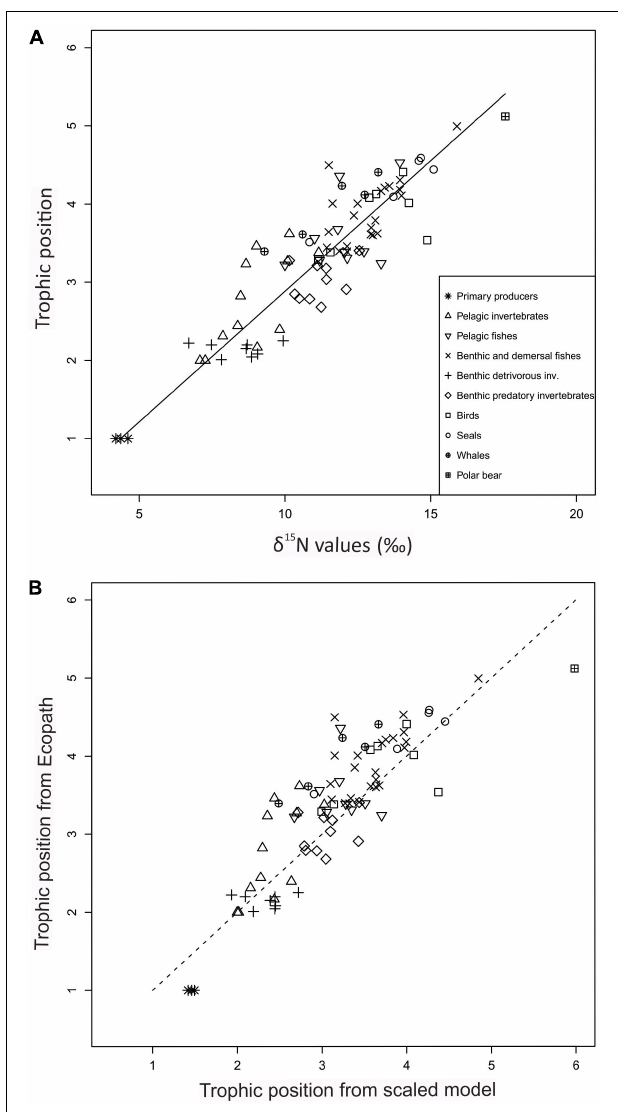
FIGURE 3 | Relationship between trophic positions estimated from Ecopath ( y -axis) and from alternative models (linear and scaled) from δ 15 N values for 83 functional groups ( x -axis) for the Barents Sea for both open water and fjord habitats. Symbols show FGs in major categories. (A) Trophic position estimated from Ecopath ( y -axis) and line shows trophic positions predicted by linear best-fit model from δ 15 N values ( x -axis) [TP lin = 1 + ( δ 15 N + 4.4)/3.0]. (B) Trophic position from Ecopath (TP ec , y -axis) and trophic position estimated by scaled model (TP sca ) from δ 15 N values (Eq. 3, x -axis) for functional groups. Stippled line show (1:1) line. In the scaled model, baseline TP (TP base ) was 2.0 and baseline δ 15 N value ( δ 15 N base ) was set to